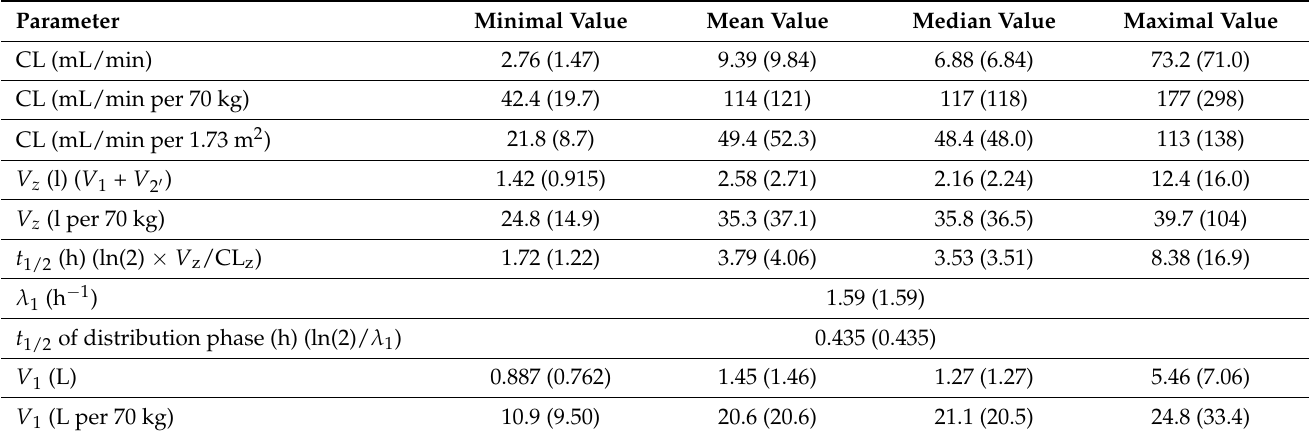
Table 4. Ranges of PK parameters for the final model and for the studied patient population. Population level (individual level). Parameter Minimal Value Mean Value Median Value Maximal